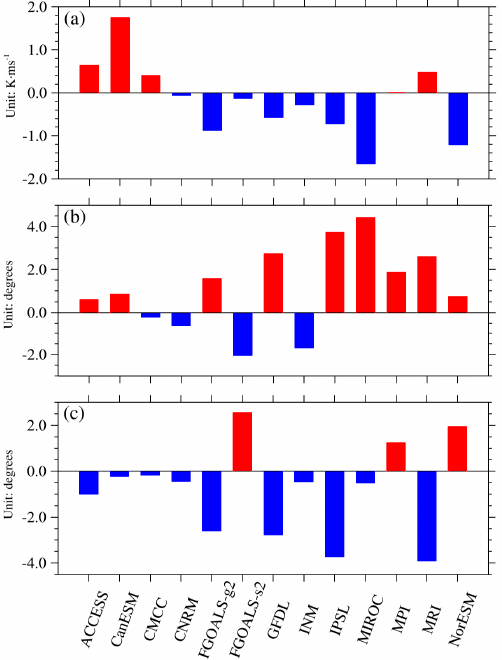
Figure 7. Difference of ( a ) strength index, ( b ) longitude index and ( c ) latitude index of winter climatological mean between the CMIP5 models and NCEP reanalysis.